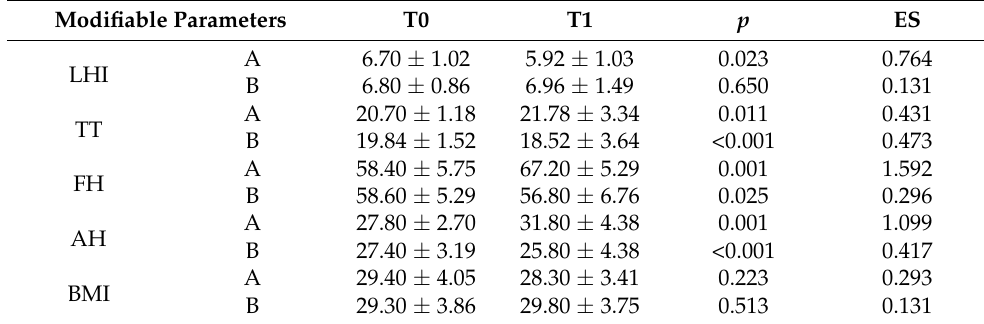
Table 3. The evolution of modifiable parameters in the two